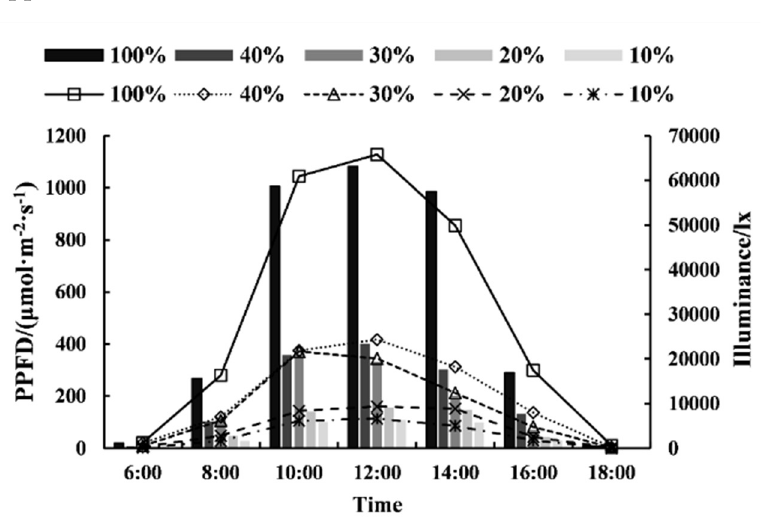
Figure A1. Daily variation trend of light intensity under different management types for Ma bamboo. Note: The line graph represents the daily change in PPFD, and the bar graph represents the daily illuminance change. L0, L1, L2, L3, and L4 refer to 100%, 40%, 30%, 20%, and 10% of natural light, respectively.